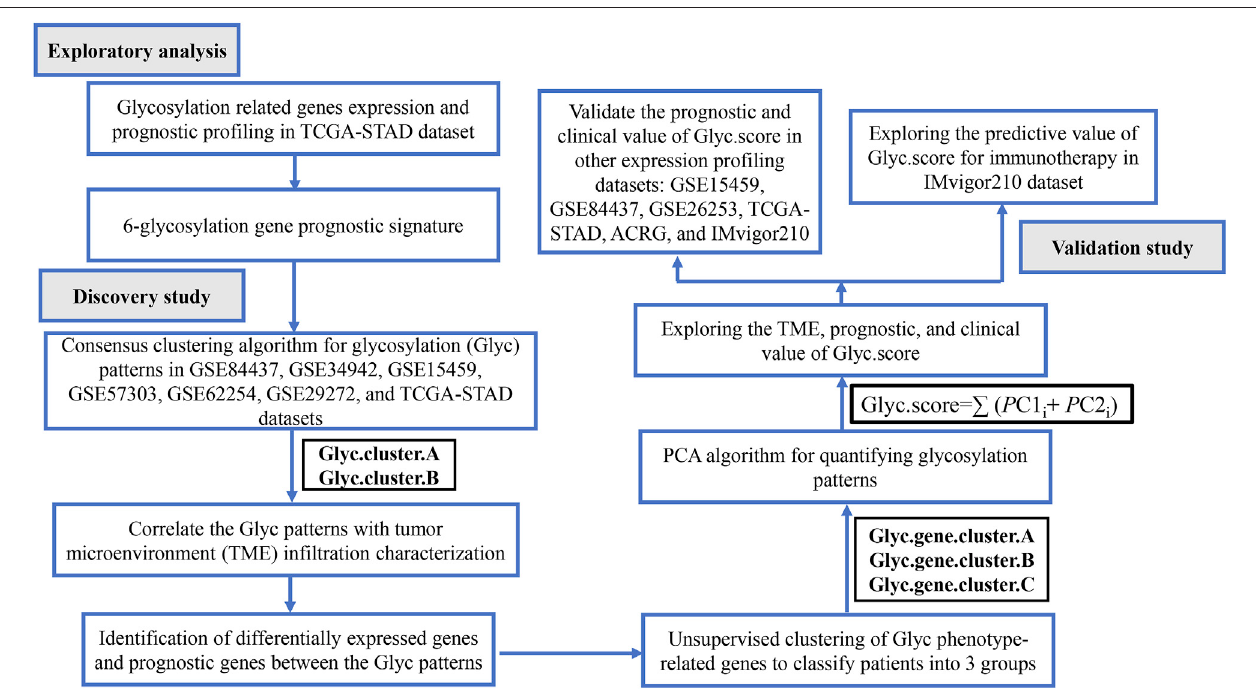
FIGURE 1 | Flow chart of the